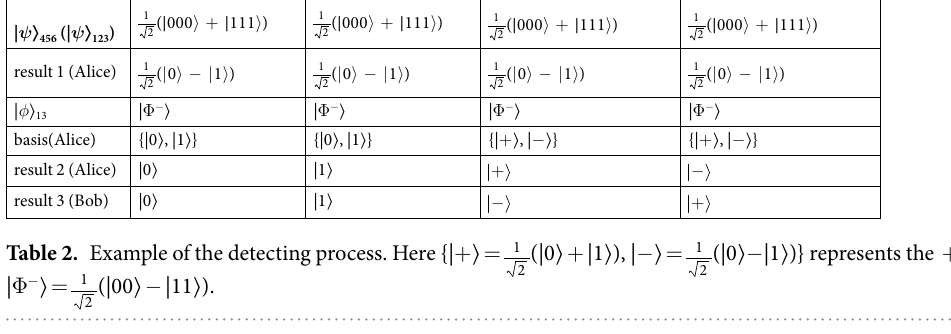
Table 2. Example of the detecting process. Here {| + 〉 = 1 | Φ − 〉 = 1 (|00 〉 − |11 〉 2